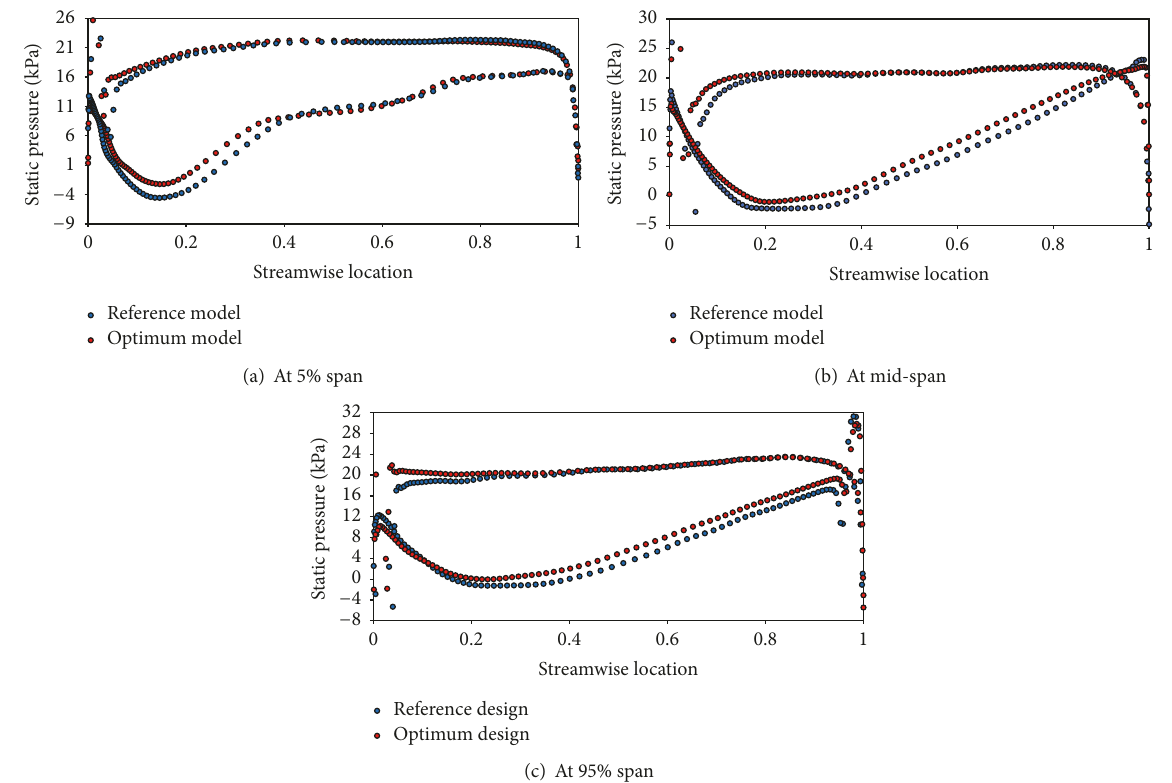
Figure 9: Static-pressure distributions on the blade surfaces of the rear